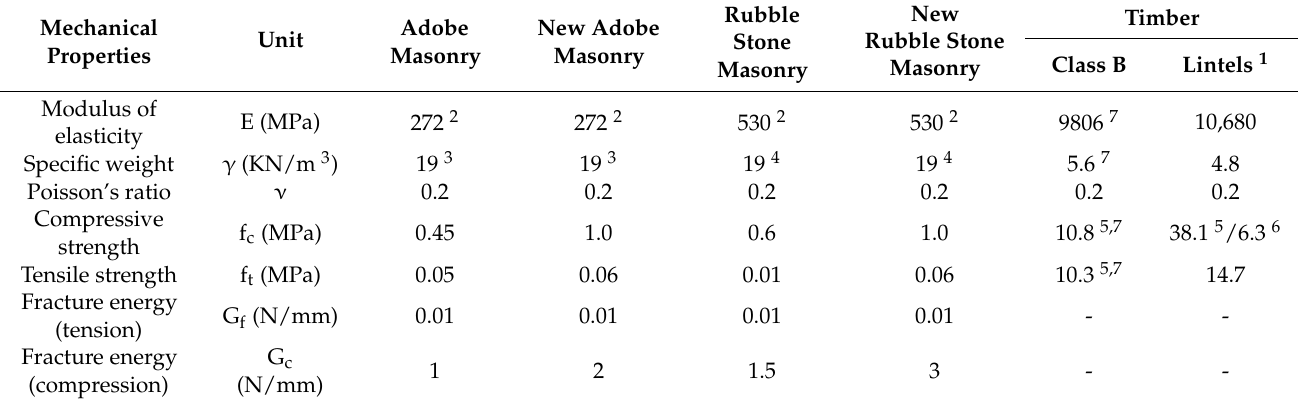
Table 3. Mechanical properties of adobe masonry, rubble stone masonry and timber